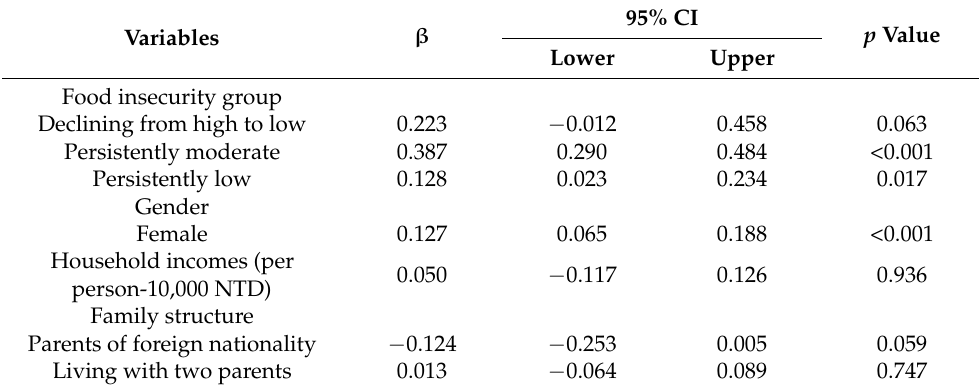
Table 3. The association between sleep problems and food insecurity